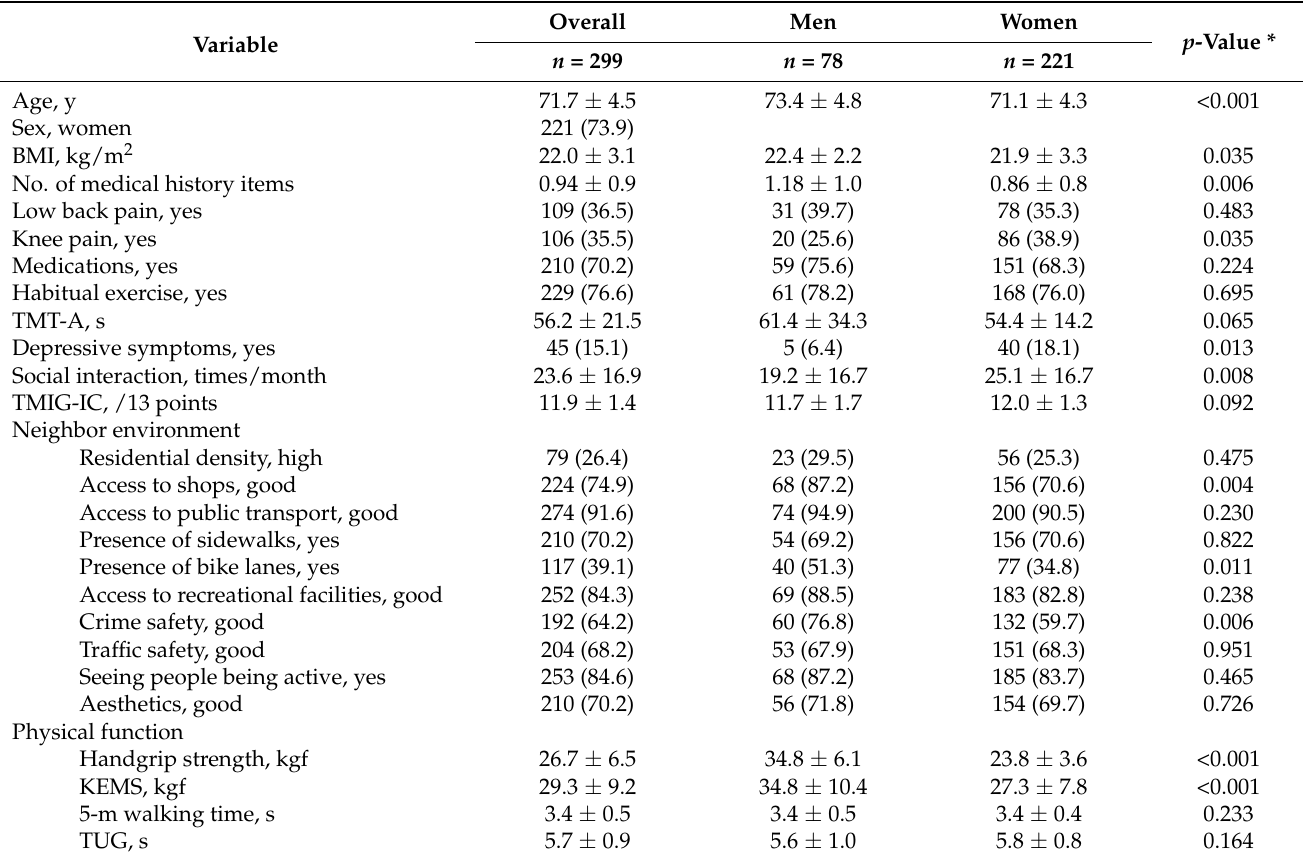
Table 1. Participant characteristics at